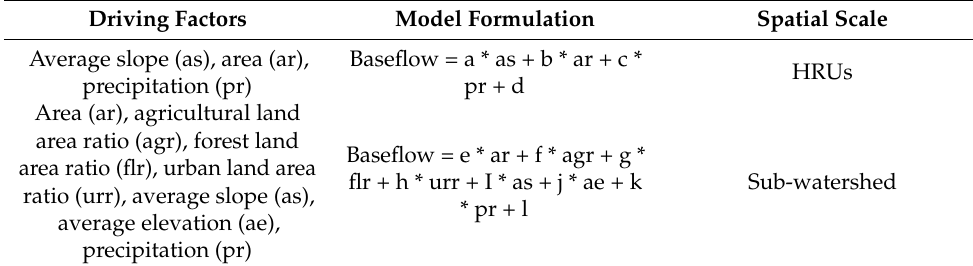
Table 1. MLR formulations with different